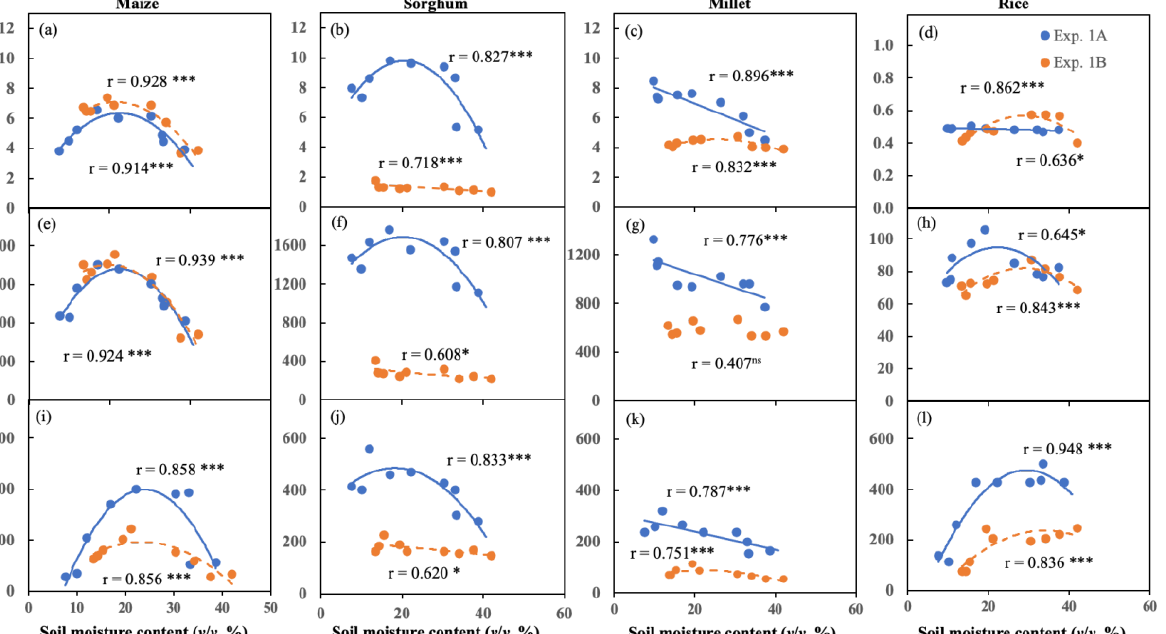
gs (Figure 2b,f,j). In millet, the nonlinear and linear correlation between soil moisture